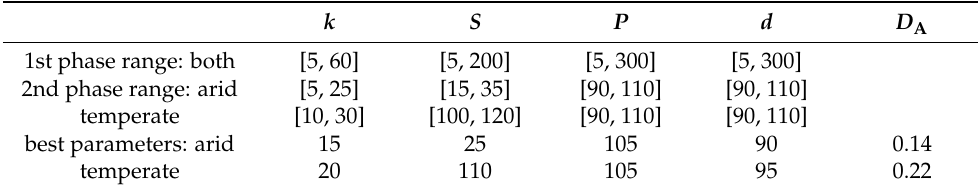
Table 1. Segmentation parameters, images acquired in arid and temperate